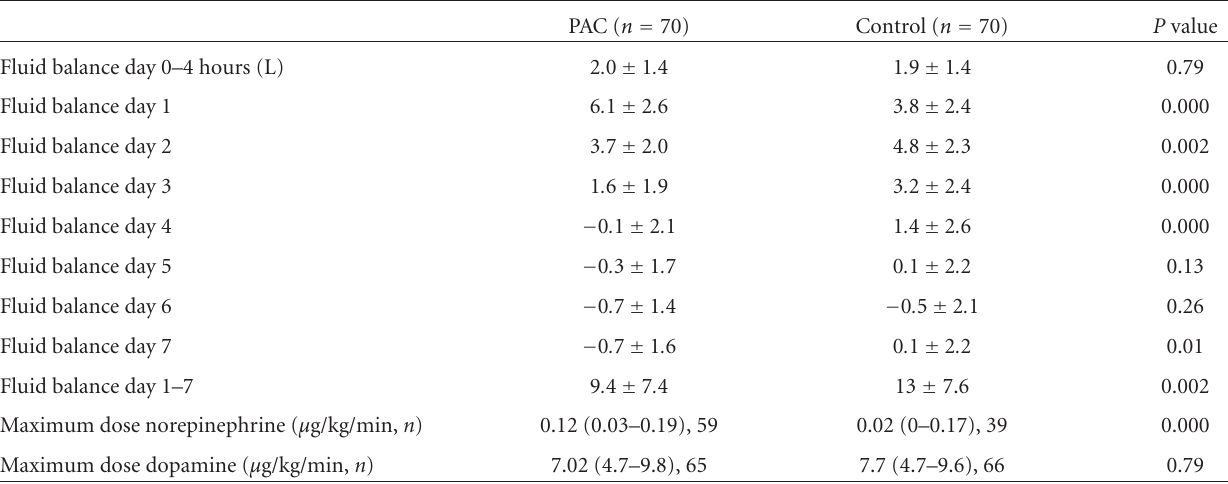
Table 2: Primary outcome variables: fluid balance and use of vasoactive